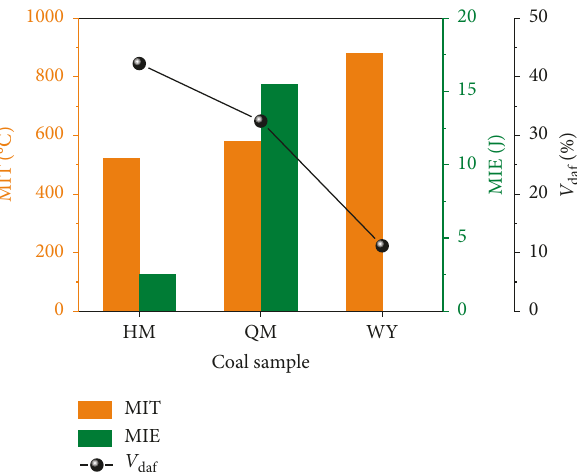
Figure 4: MIT, MIE, and volatile matter of the three coal dust samples.